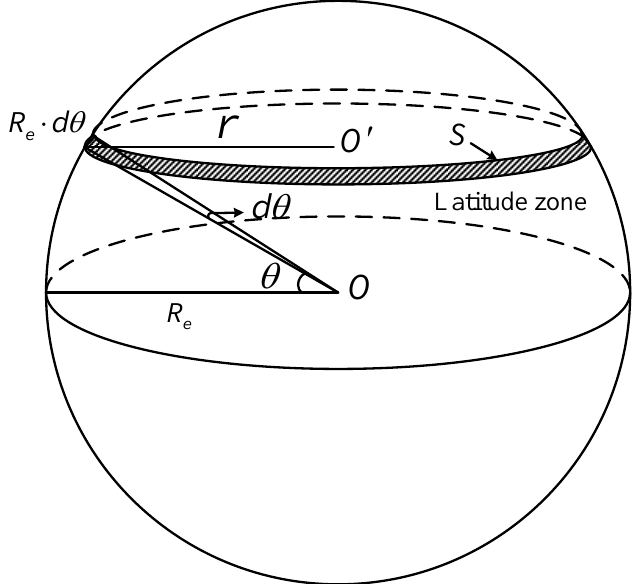
Figure 1. Schematic diagram of a latitude zone on the Earth’s surface.